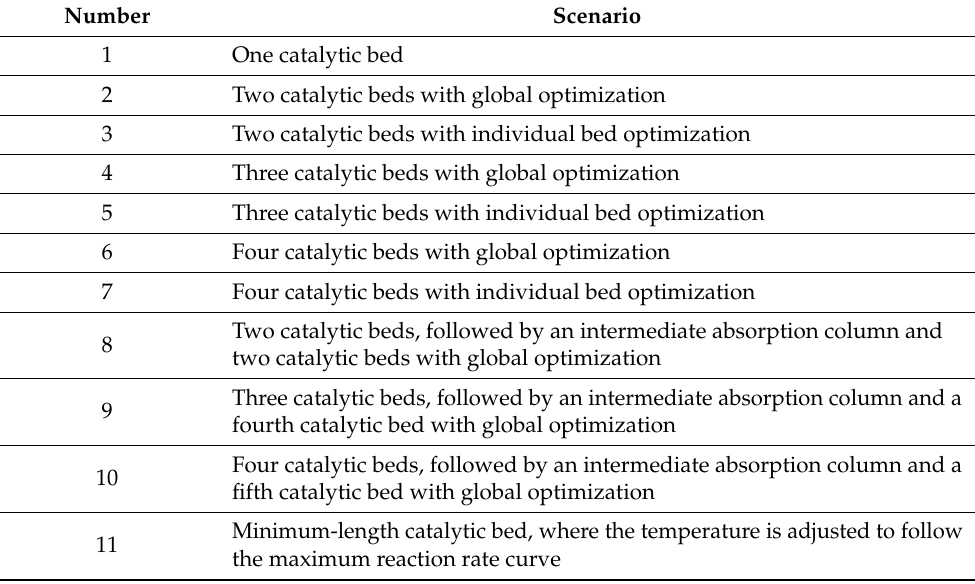
Table 6. Brief description of the various process scenarios that were optimized in this